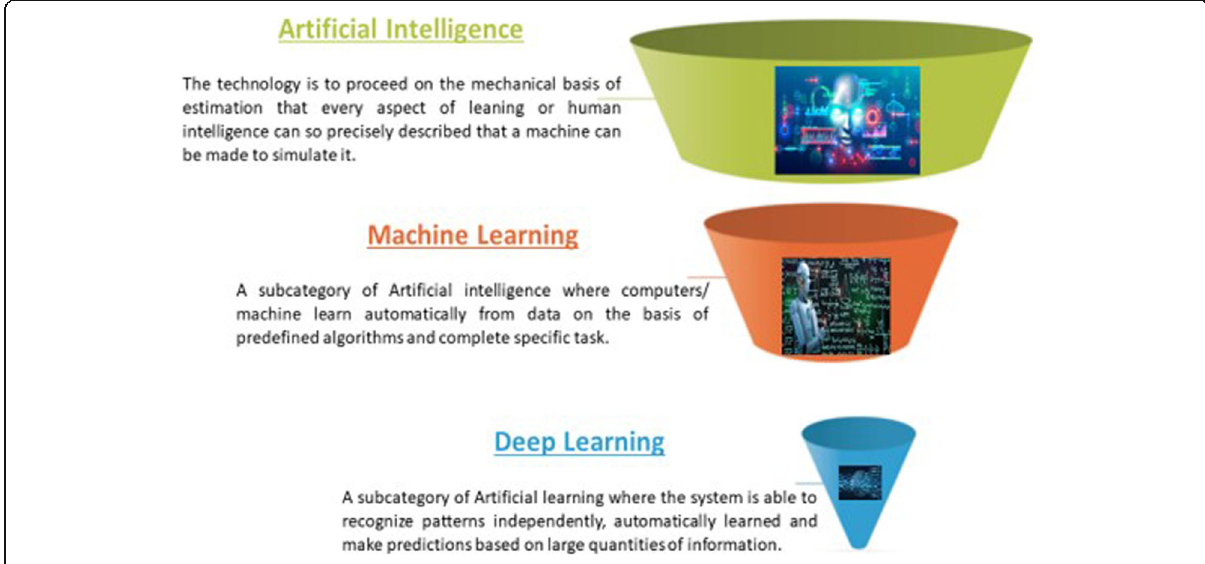
Fig. 1 Various fields of artificial intelligence and definitions